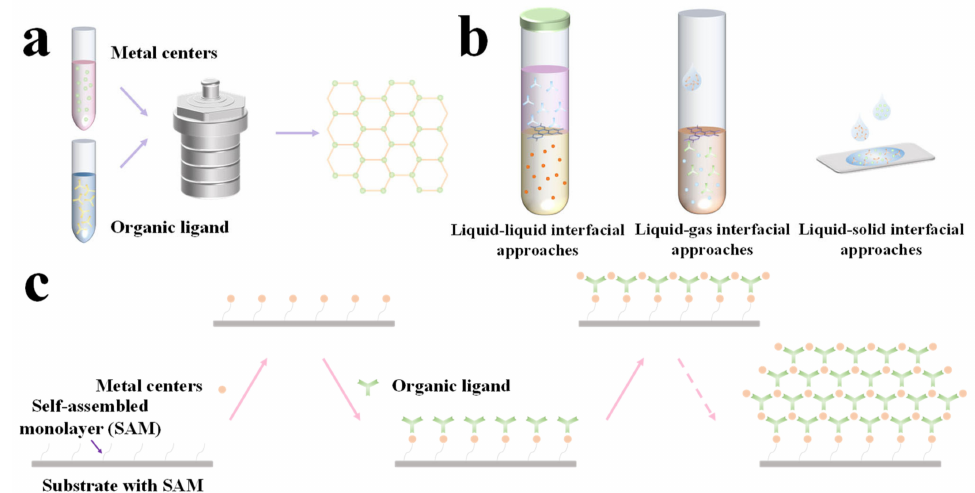
Figure 5. Strategies for the synthesis of c-MOFs. ( a ) Hydro/solvothermal synthesis, ( b ) the interfacial strategies for the synthesis of c-MOFs films, ( c ) the layer-by-layer self-assembly strategies for the synthesis of c-MOFs